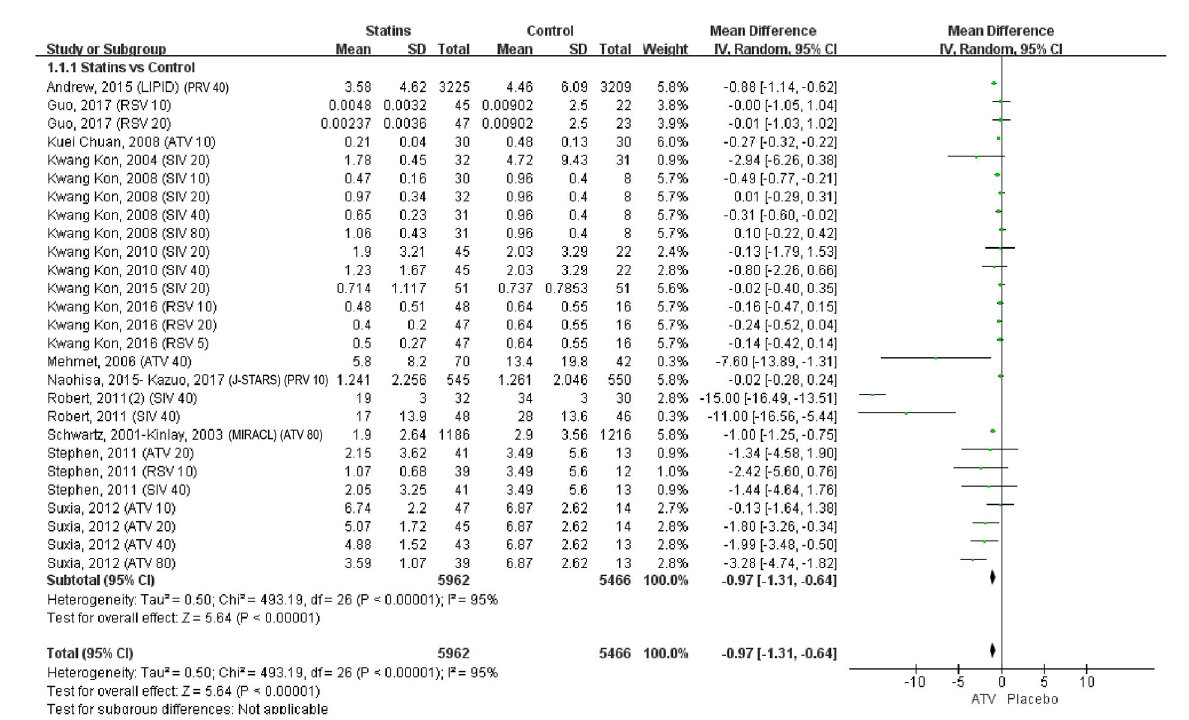
− 0.08]) and the inconsistency model (WMD = − 1.25,